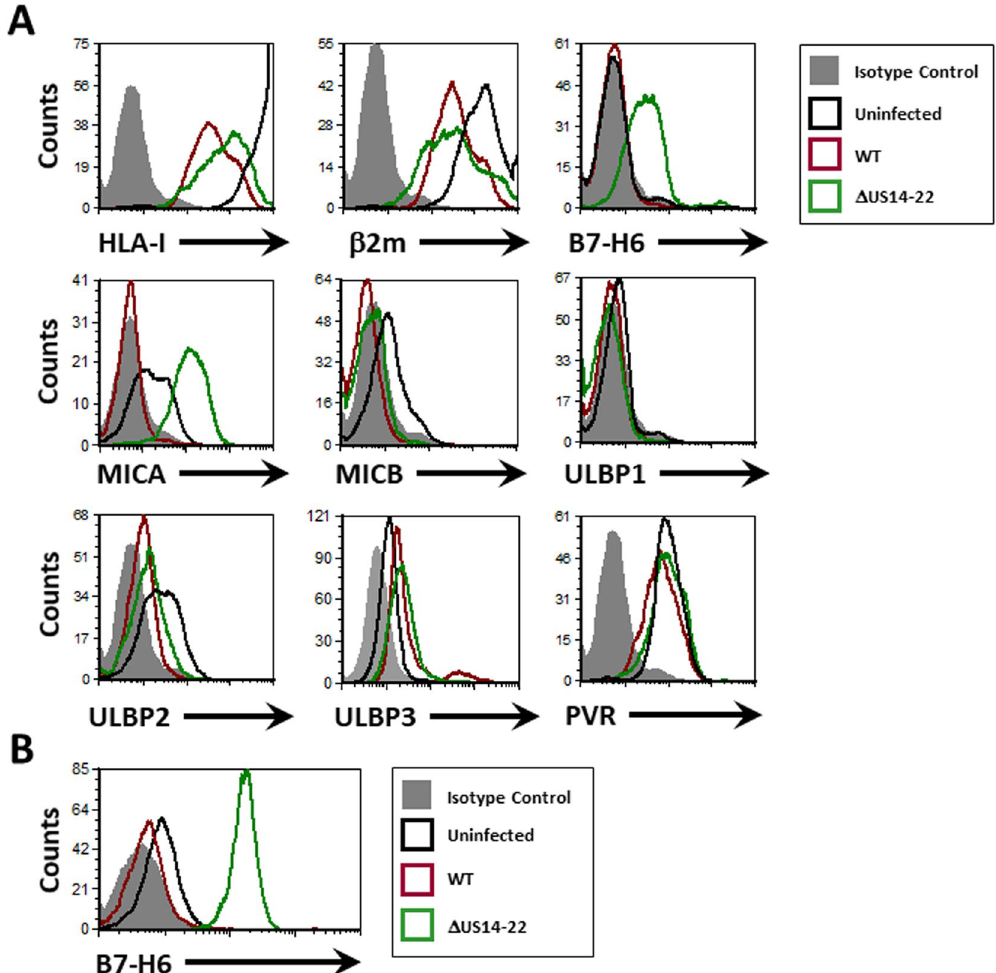
Figure 1. The HCMV US14-22 genomic region encodes several immune evasion mechanisms. ( A ) FACS staining for different NK cell ligands on Human Foreskin Fibroblast cells, 96 hours after infection with WT HCMV TB40/e or HCMV TB40/e deleted for the US14-22 genomic region (or control uninfected cells, as depicted in the figure legend). Filled gray histograms represent staining with the relevant isotype control antibodies. A representative isotype control staining derived from the uninfected cells is presented as no significant differences were observed between isotype control stainings for each infection. ( B ) FACS staining of B7-H6 surface expression on ARPE19 cells infected with different HCMV strains as depicted in the figure legend. No significant differences were observed between isotype control stainings of each infection, so a representative isotype control staining derived from the uninfected cells is